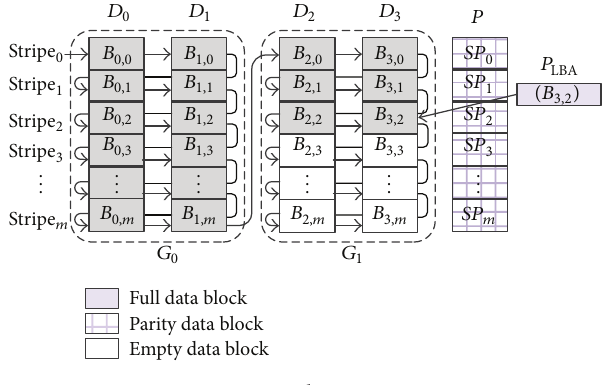
Figure 5: Sequential write in